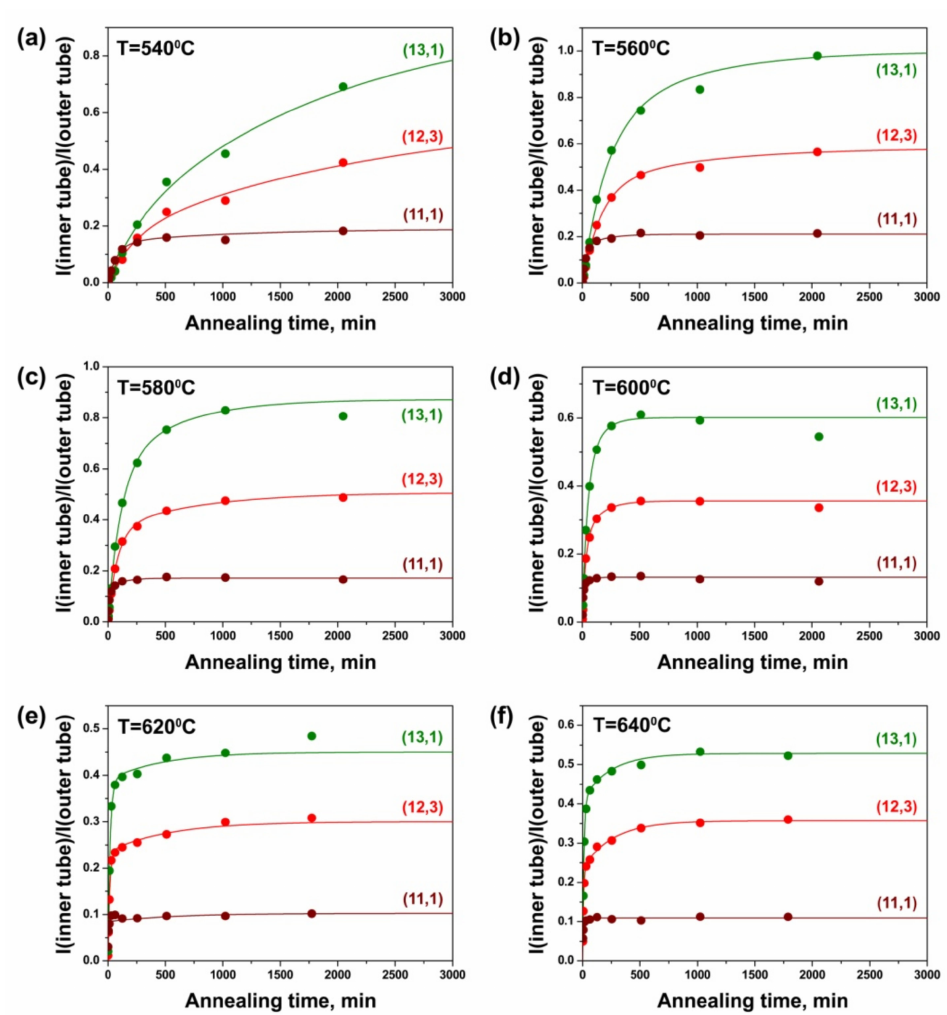
Figure 8. The integral intensity of peaks of the (12,3), (13,1) and (11,1) inner tubes normalized to the intensity of the outer tube peak observed in the RBM-band of Raman spectra of the annealed CoCp 2 -filled SWCNTs acquired at a laser wavelength of 633 nm (E ex = 1.96 eV) plotted versus annealing time. The experimental data for the samples annealed at temperatures of 540 ◦ C ( a ), 560 ◦ C ( b ), 580 ◦ C ( c ), 600 ◦ C ( d ), 620 ◦ C ( e ) and 640 ◦ C ( f ) are shown as filled circles. The fitting results of the data are presented as solid